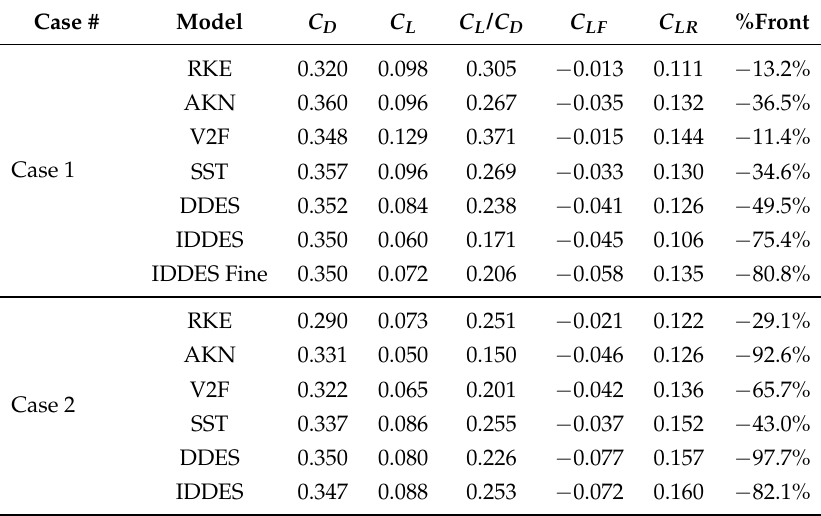
Table 2. Drag and lift coefficients for all models.